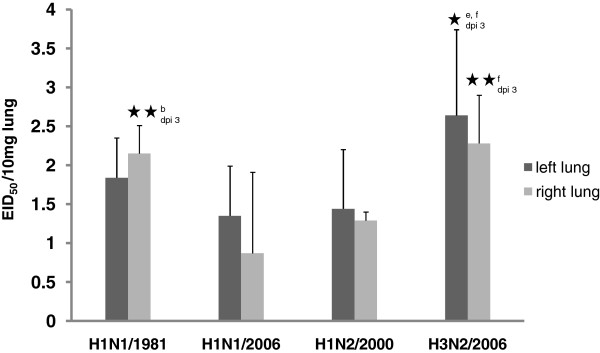
Viral lung load. Viral lung load (EID50/10 mg lung) in pigs 3 days after aerosol infection with swine influenza A viruses; statistics: asterisk (1 p < 0.05, 2 p < 0.010, 3 p < 0.005, comparison of following groups: a H1N1/1981:H1N1/2006, b H1N1/1981:H1N2/2000, c H1N1/1981:H3N2/2006, d H1N1/2006:H1N2/2000, e H1N1/2006:H3N2/2006, f H1N2/2000:H3N2/2006).